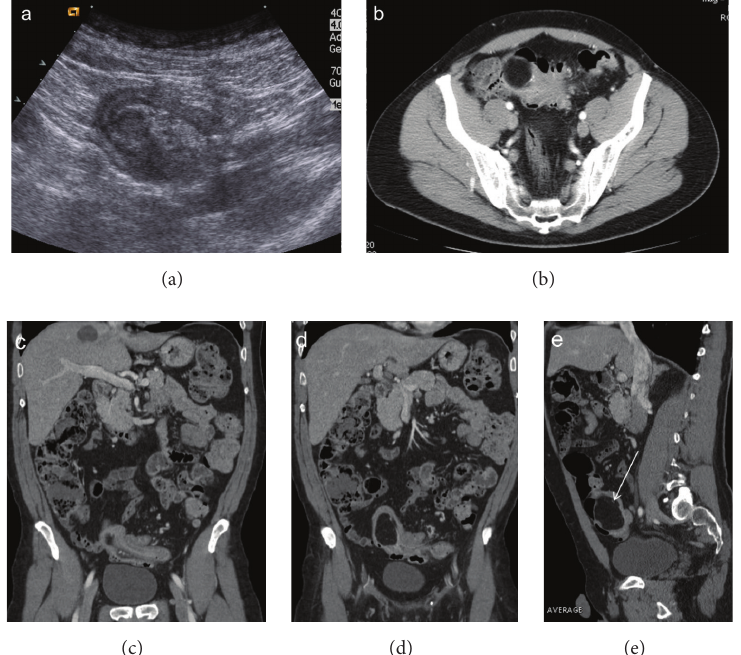
Figure 5: Colocolonic (sigmoid) intussusception caused by a lipoma. Ultrasound scan (a) shows a pelvic layered ovoid mass. CT images on axial (b) and oblique reformatting (c, d) demonstrate an intraluminal lesion with fat attenuation (arrow) that serves as the intussusception lead